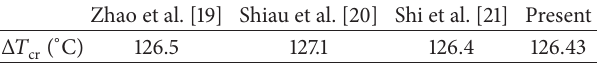
Table 1: Critical buckling temperature of the isotropic panel.